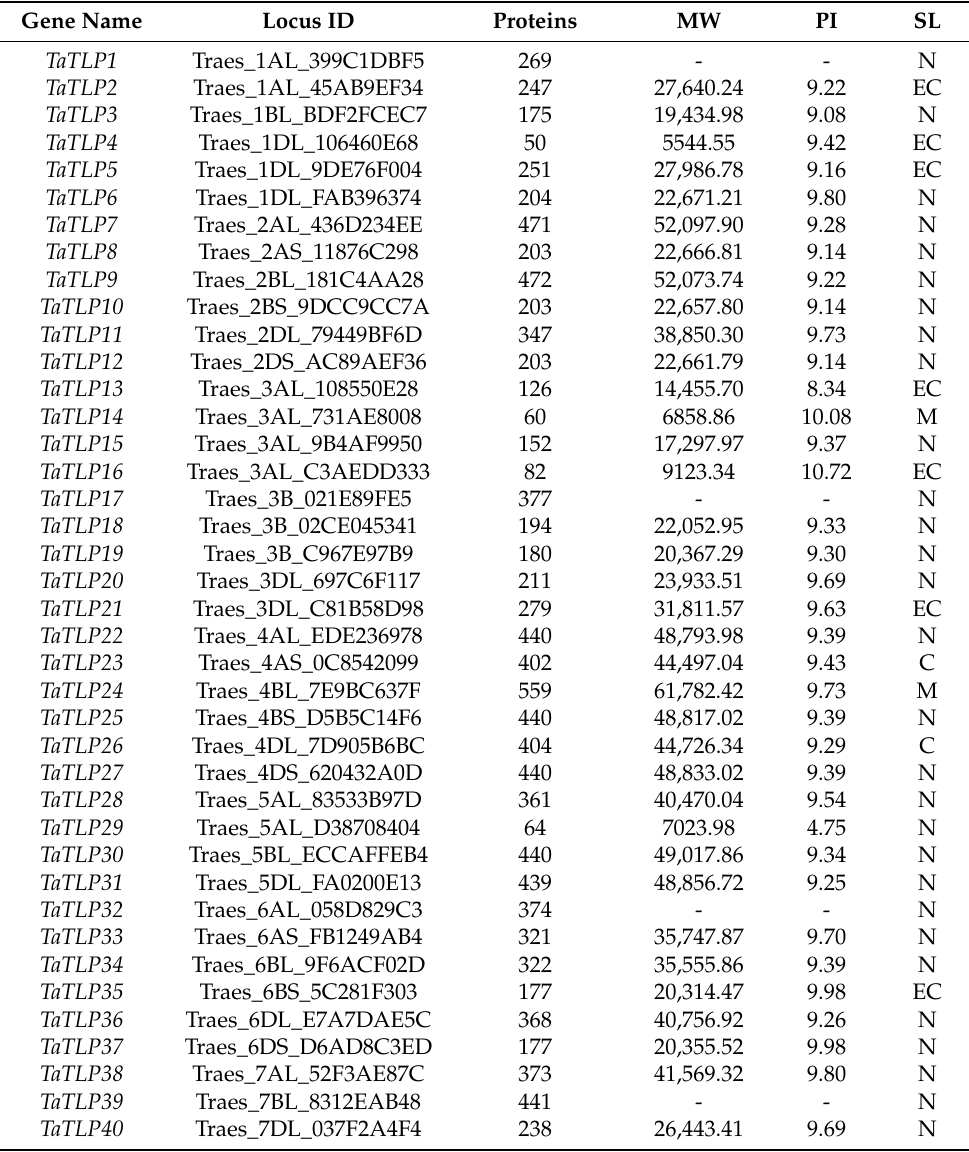
Table 1. The gene features of the wheat TUBBY gene